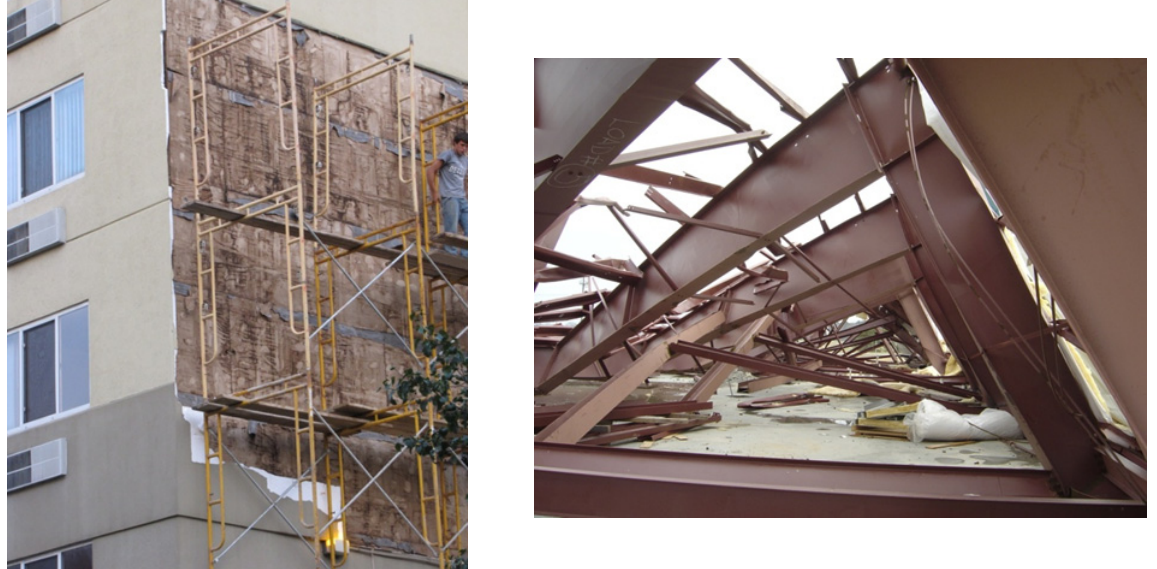
Figure 1. EIFS Façade Failure Due To Wind and Anchorage Conditions (Left). Complete Collapse of Engineered Metal Building During Construction (Right); Photos by